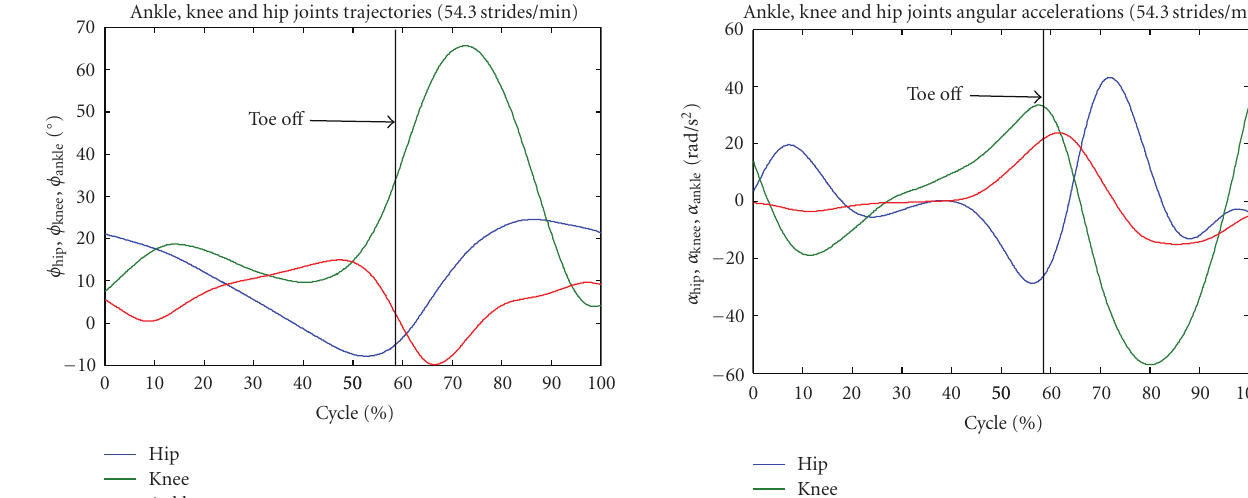
and their first